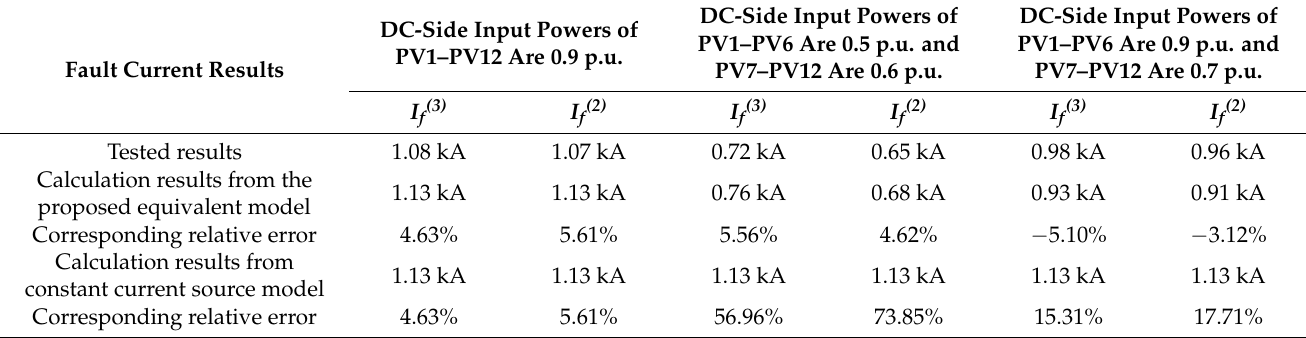
Table 2. Tested simulation and calculated theoretical results of the fault current provided by the PV station after the fault f 1 .